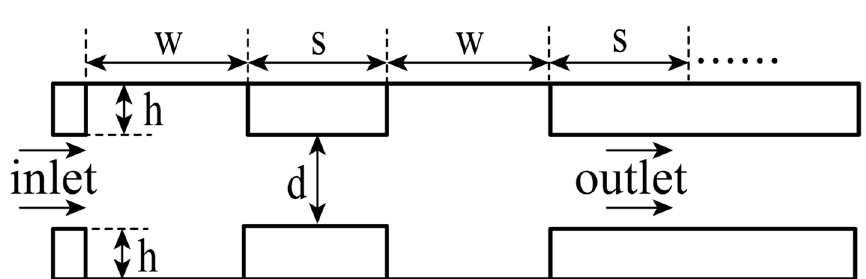
Figure 7. BCT schematic diagram.